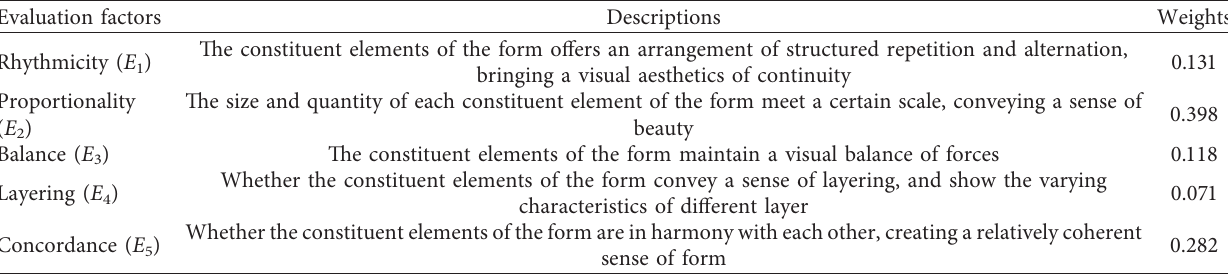
Table 11: Description of evaluation methods and relative weight.